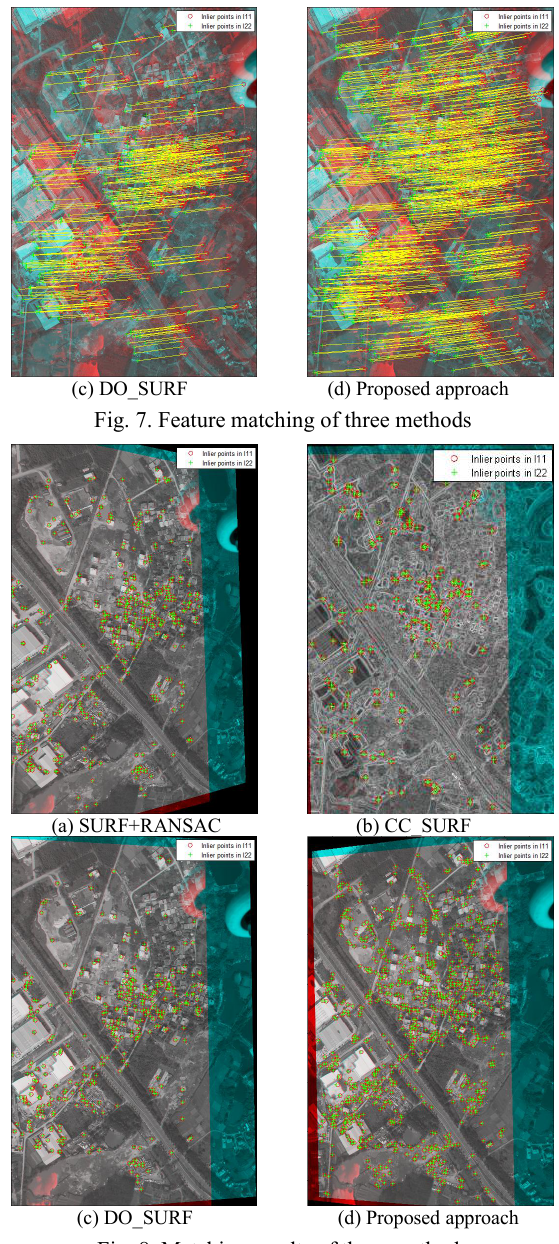
Fig. 8. Matching results of three methods